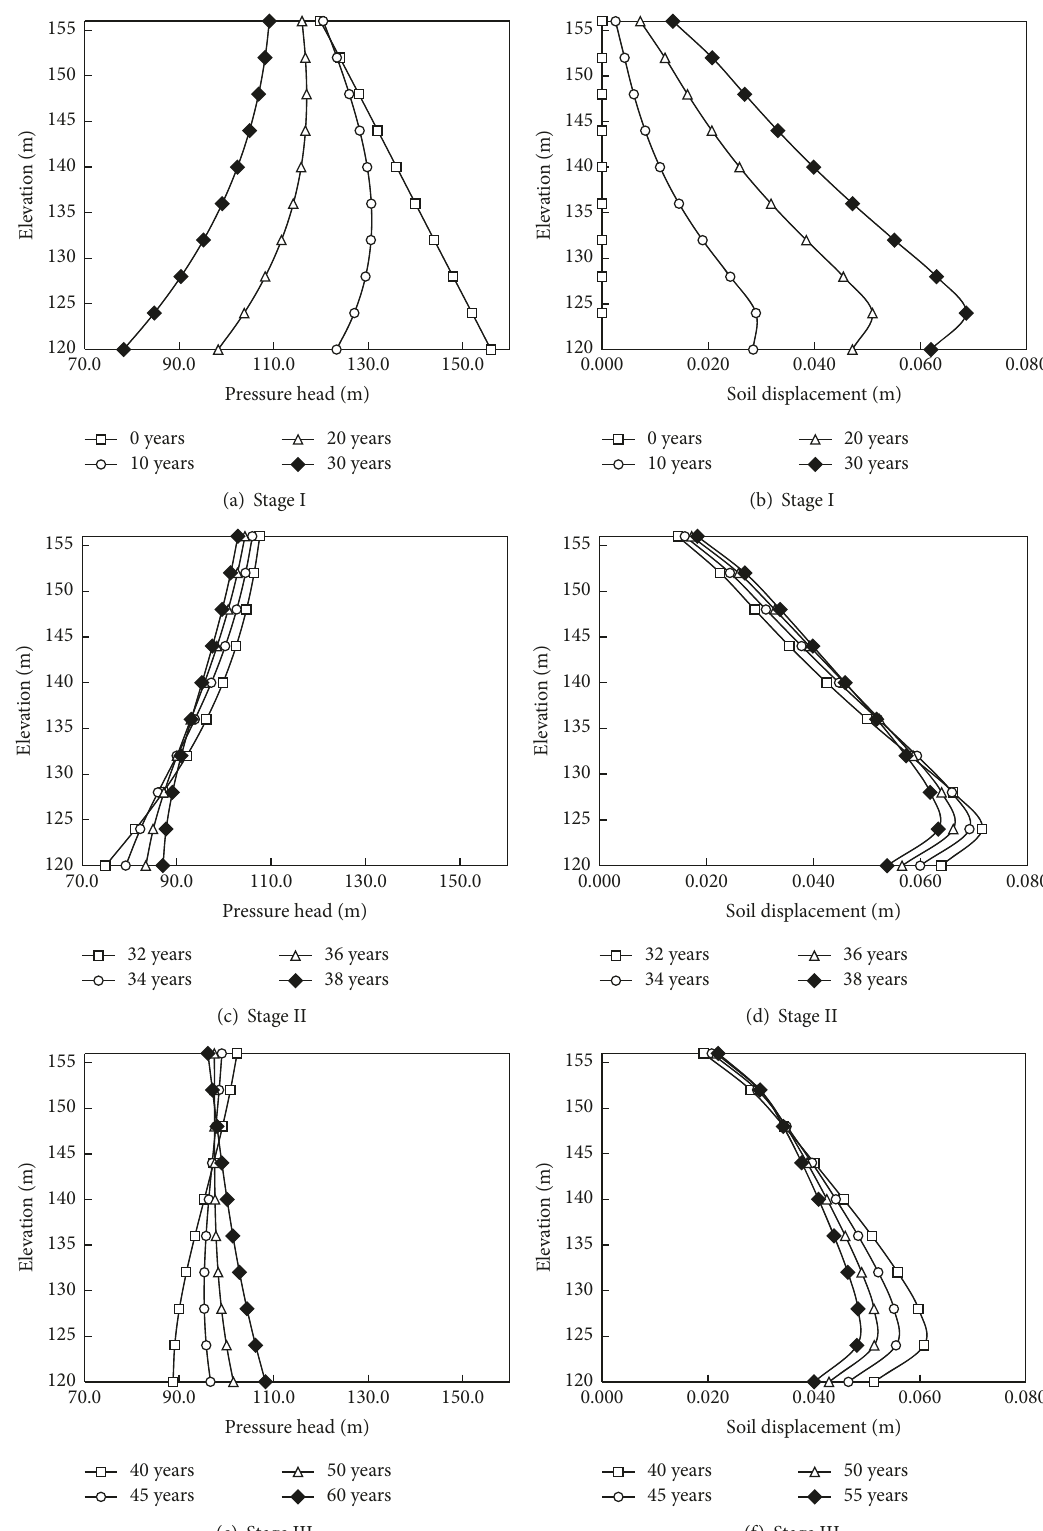
Figure 5: Distributions of pressure head and soil displacement in aquitard II during different